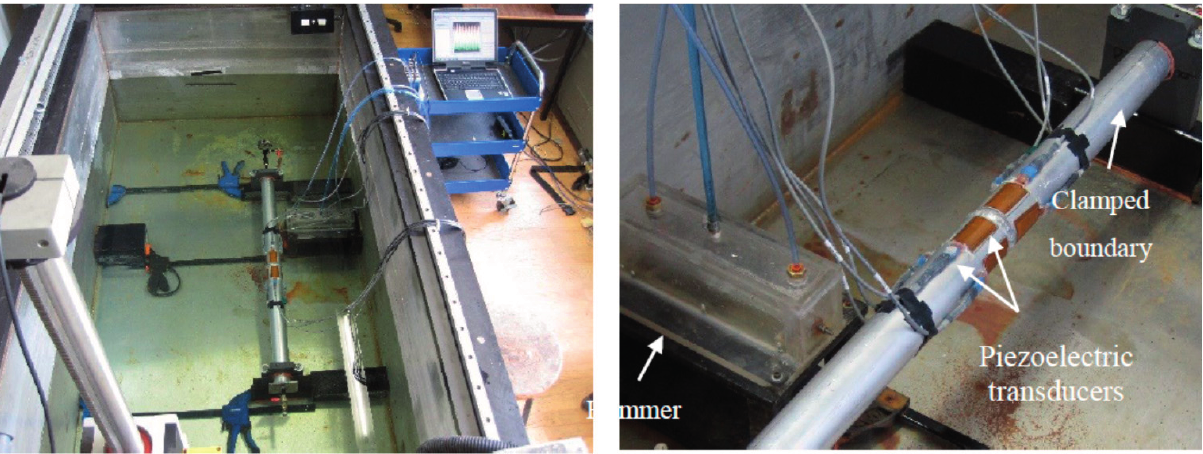
Figure 5. Schematic of the experimental setup for conducting the damage detection trials.